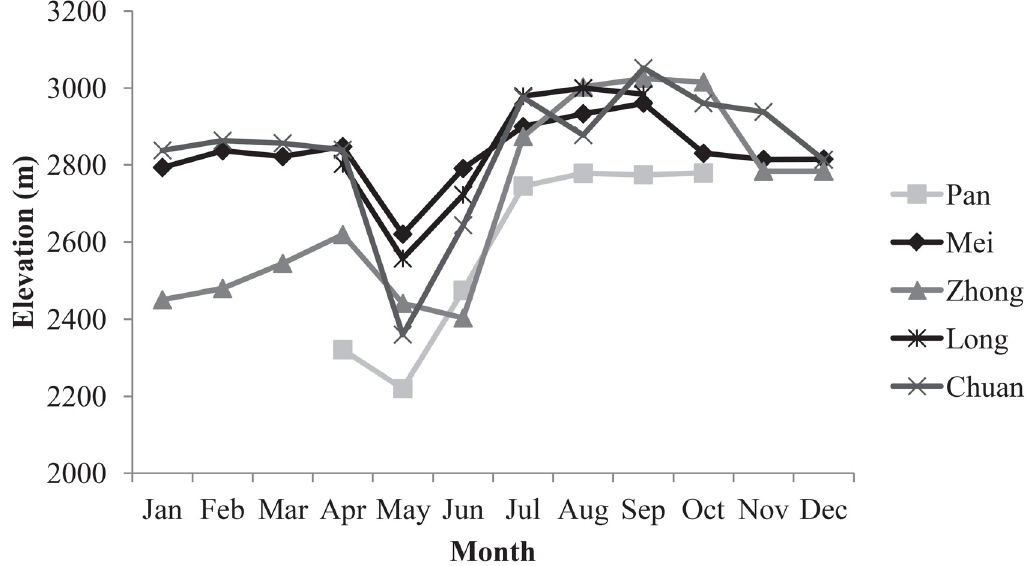
Fig 3. Habitat use of GPS-collared giant pandas with respect to elevation over time. Values shown are the means for each month after randomly selecting one point per day. Chinese names refer to individual pandas.